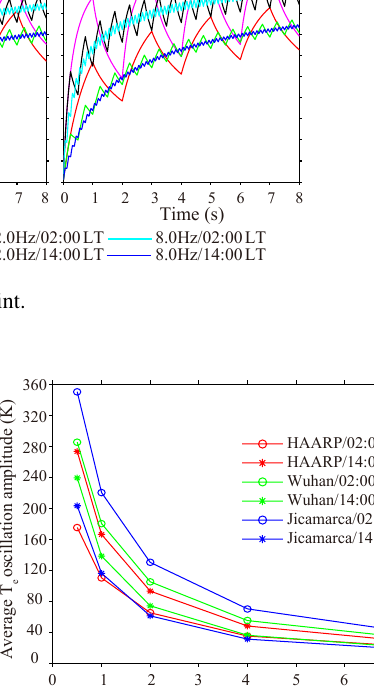
Figure 5. The variation of the average electron temperature oscilla- tion amplitude with different modulation